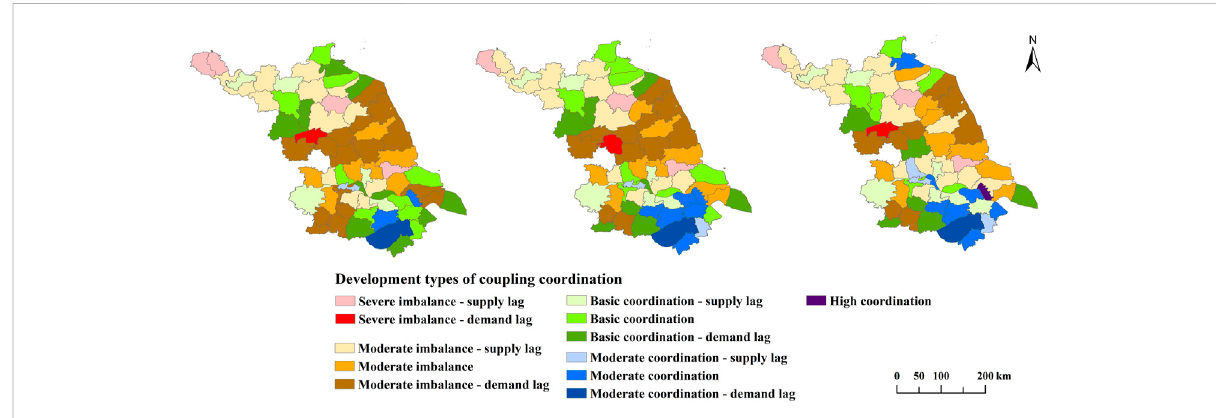
FIGURE 6 Types of coordinated development in the supply and demand coupling of ecosystem services in Jiangsu